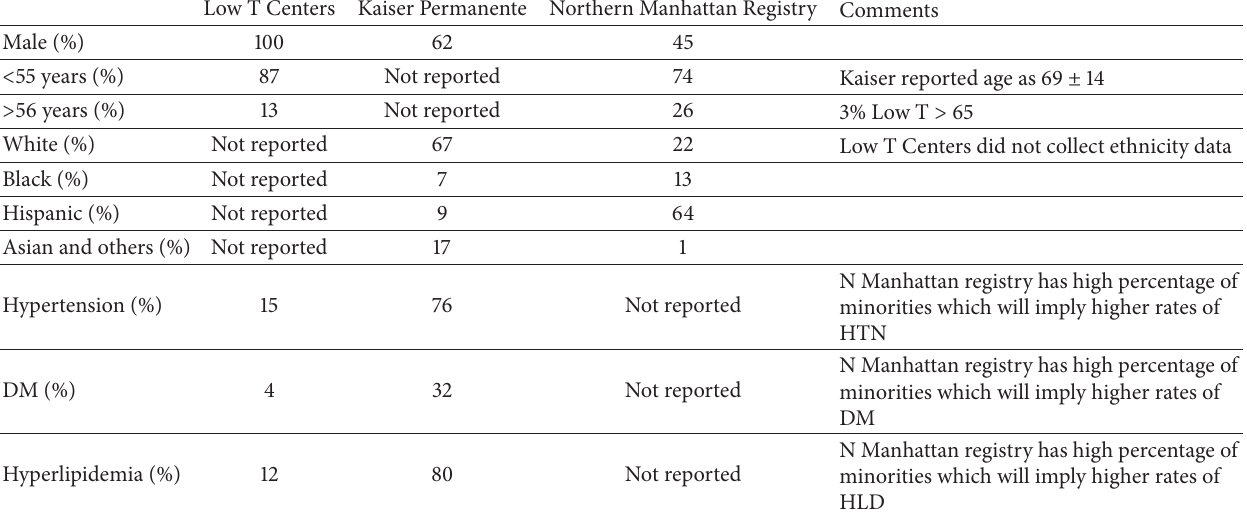
Table 2: Characteristics of Low Testosterone (T) Center patients in comparison to controls from other registry